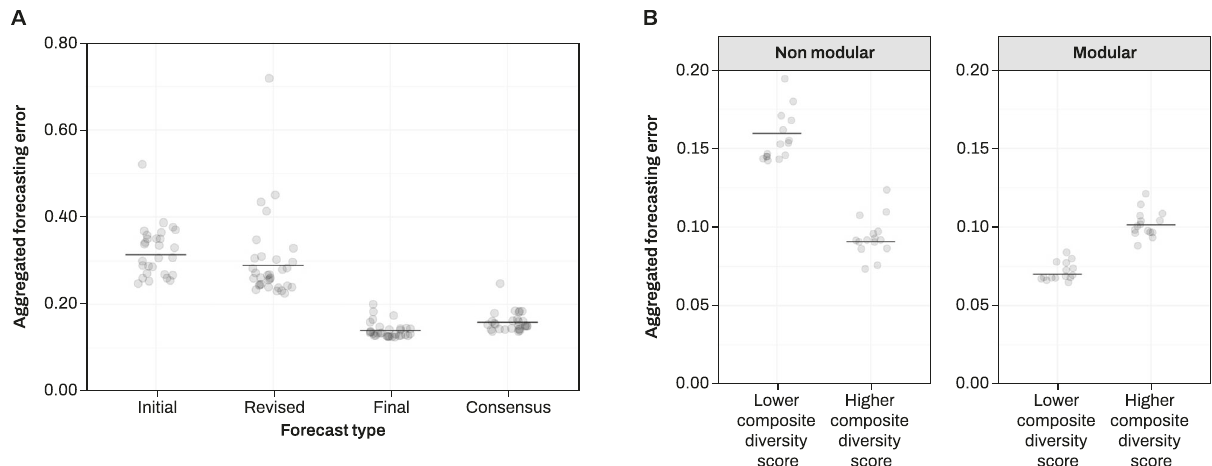
Fig. 3 Group-level analysis. Individual forecasts were aggregated for each forecast type, fi rst within each group and then across groups in each treatment. A Partial residuals plot showing the effect of forecast type on aggregated forecasting error (measured in Brier scores). Lower numbers represent higher accuracy. Solid lines represent model fi t. B Partial residuals plot showing the effect of diversity and modularity on aggregated forecasting error. Solid lines represent model fi t. Notice that the graphs have been plotted onto the original error scale. See Supplementary Fig. 11 when using a logit link. Source data are provided as a Source data fi